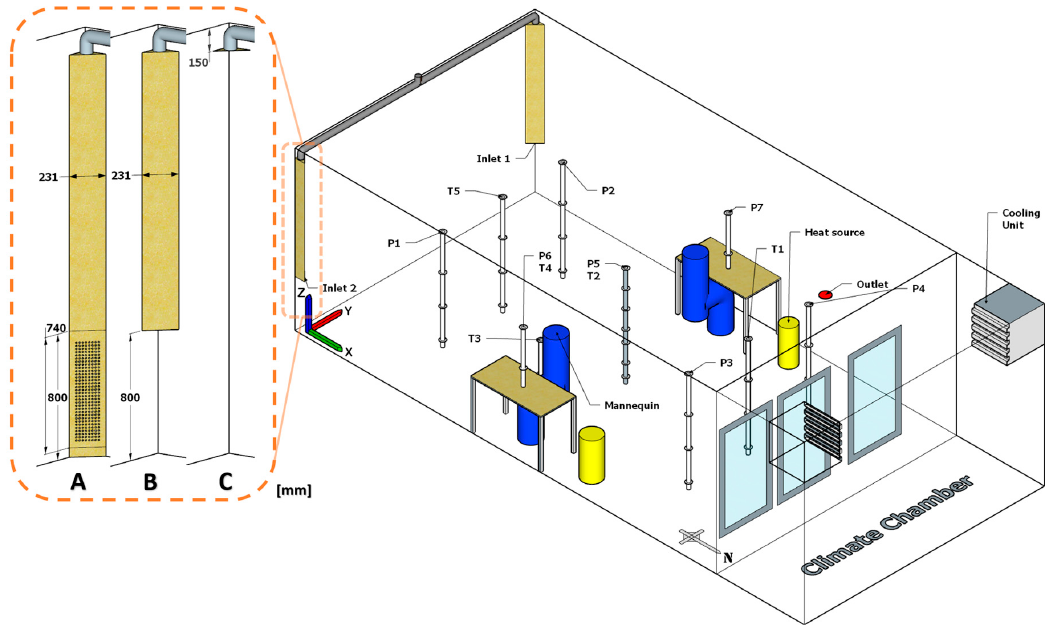
Figure 1. Layout of the office room and climate chamber. Three supply devices are illustrated for hybrid displacement ventilation (HDV, A ), corner impinging jet ventilation (CIJV, B ) and corner mixing ventilation (CMV, C ).